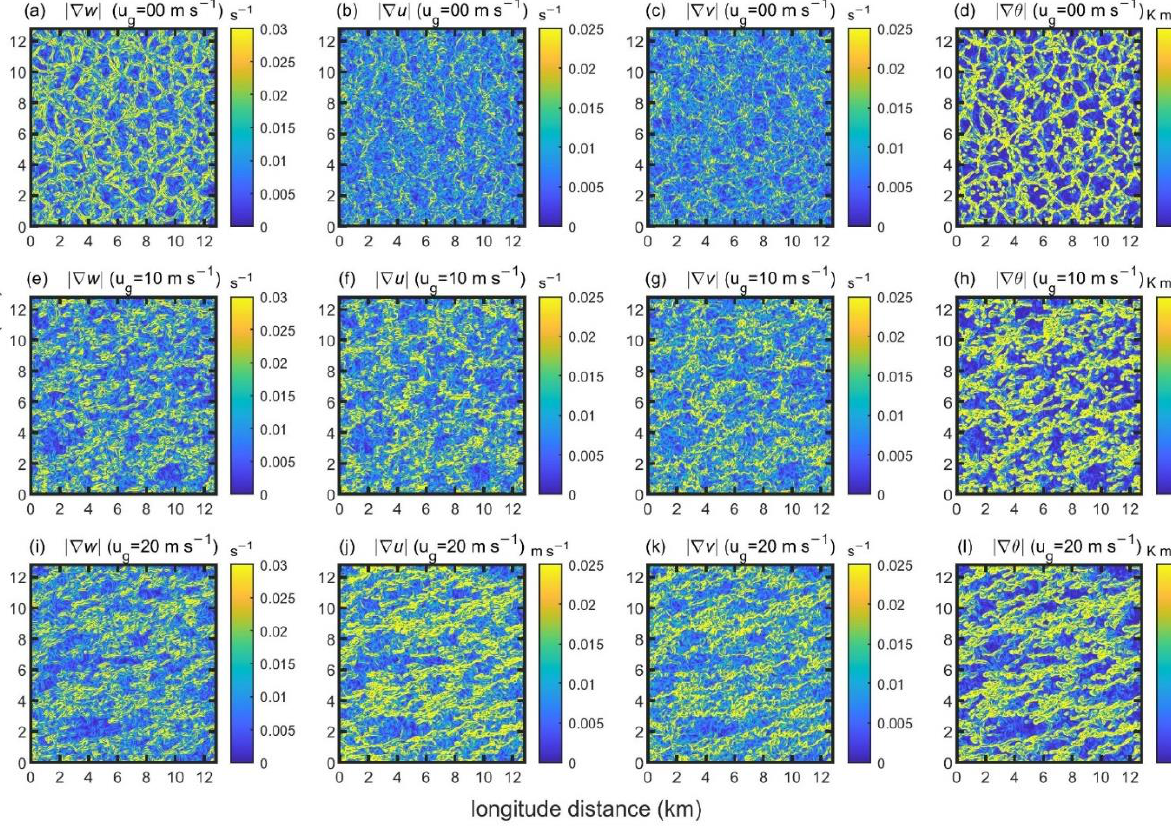
Figure 6. As in Figure 4, but at z / z i = 0.1.